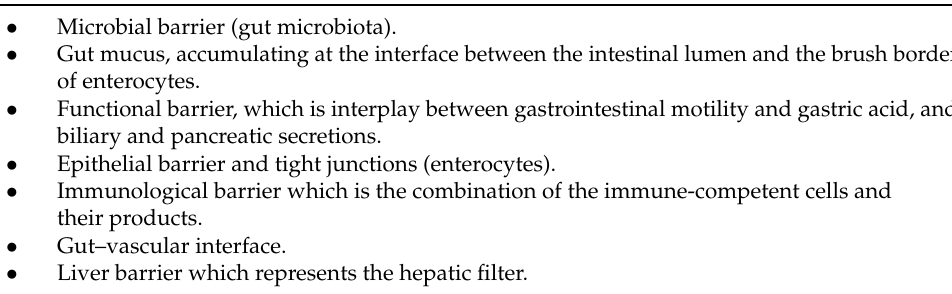
Table 1. Different physical and anatomical layers contributing to the intestinal